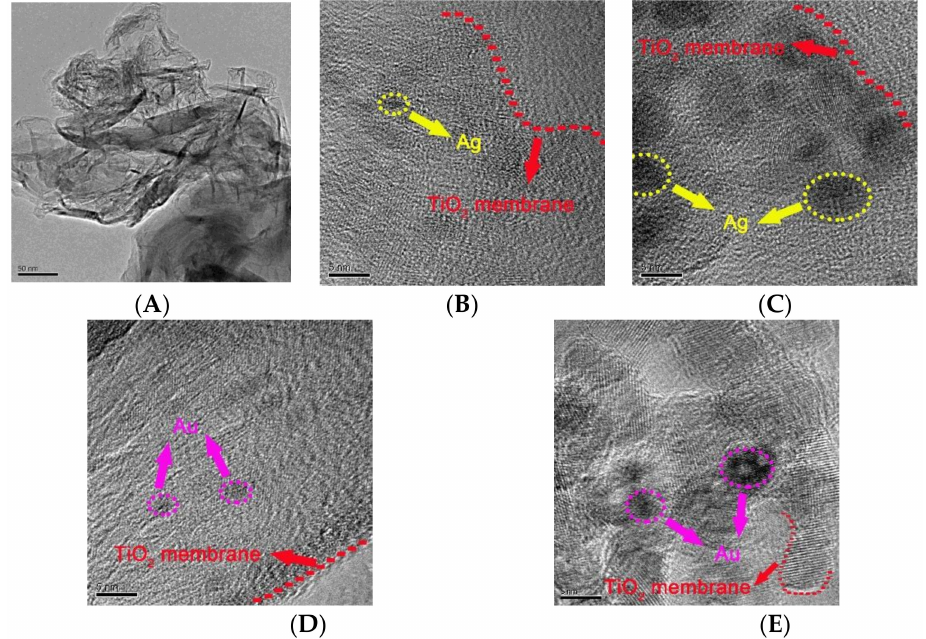
Figure 1. TEM images of the TiO 2 membrane and those decorated with Ag or Au NPs. ( A ) TiO 2 membrane; ( B )TiO 2 membranedecoratedwithAgNPsbyUVirradiation; ( C )TiO 2 membranedecoratedwithAgNPsby hydrothermal synthesis; ( D ) TiO 2 membrane decorated with Au NPs by UV irradiation; ( E ) TiO 2 membrane decorated with Ag NPs by hydrothermal